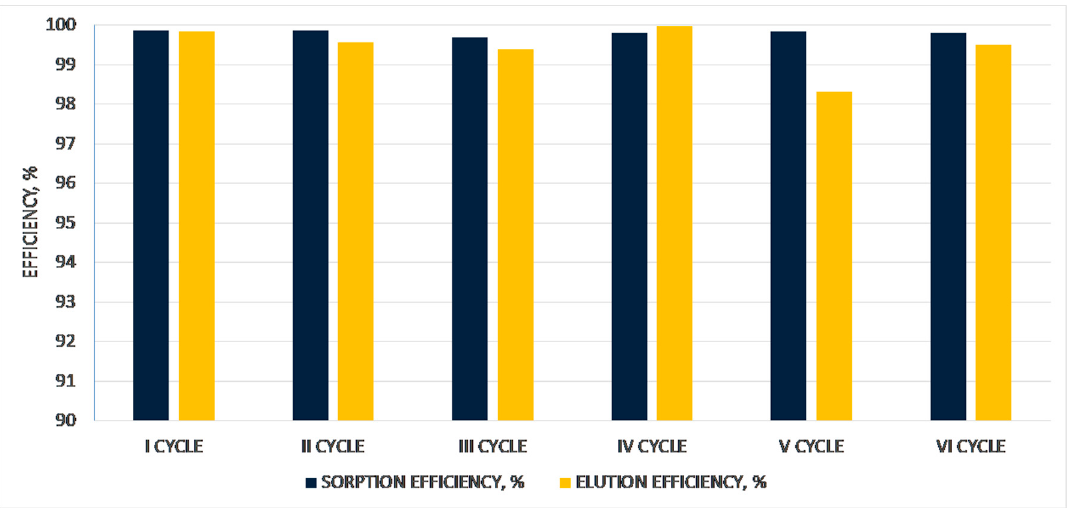
Figure 4. Sorption and elution efficiency of chromium(III) ions in six subsequent cycles of ionite PFC100 × 10 work.